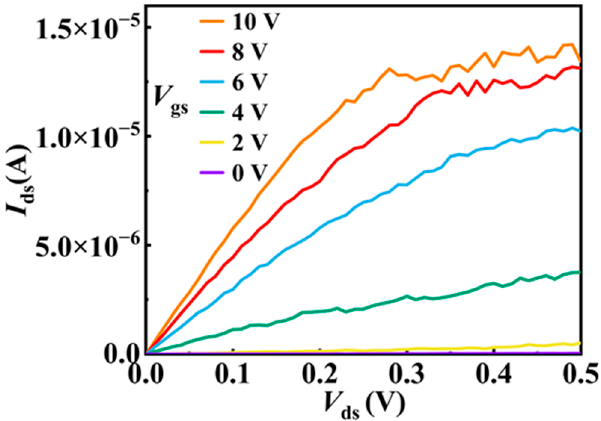
Figure 4. The output characteristic curves of the P(VDF-TrFE)-coated InAs NW device.